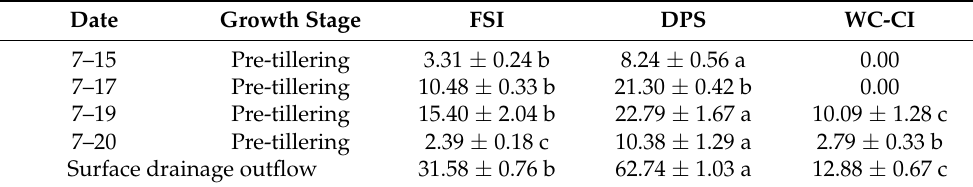
Table 3. The surface runoff under different irrigation and drainage modes (mm).